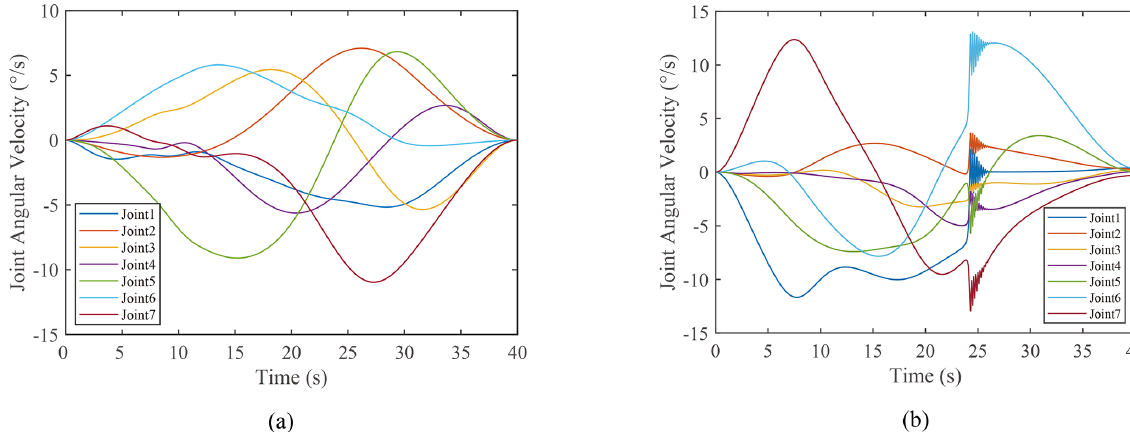
Figure 12. The change of joint angular velocities. (a) Solution 2. (b) Solution 3.